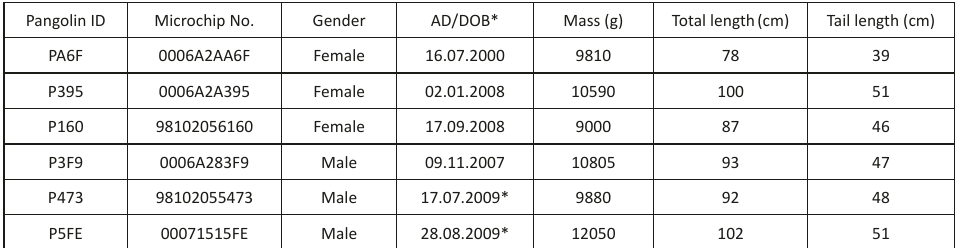
Table 1. Information about gender, body weight, length and date of birth (DOB) or date of acquisition (AD) of pangolins studied at Nandankanan. Body length and weight were measured on 18 March 2012. DOB data are shown with an asterisk. Pangolin ID Microchip No.